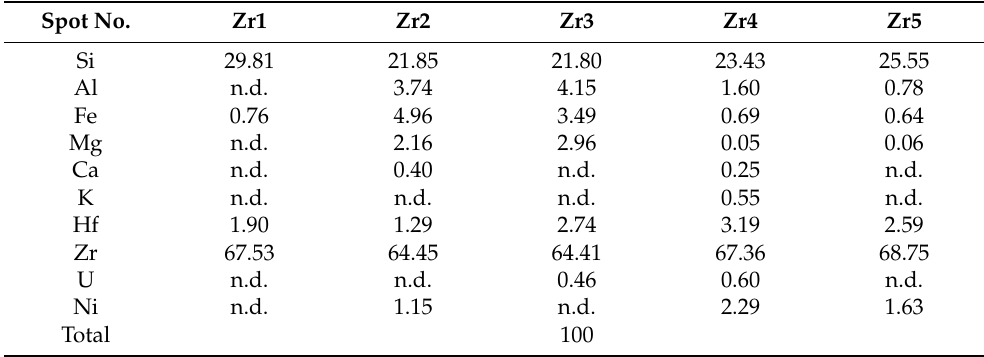
Table 2. The semiquantitative results (oxides, wt%) of EDS analyses of zircon grains from monzo- granite at Monqul, north Eastern Desert,